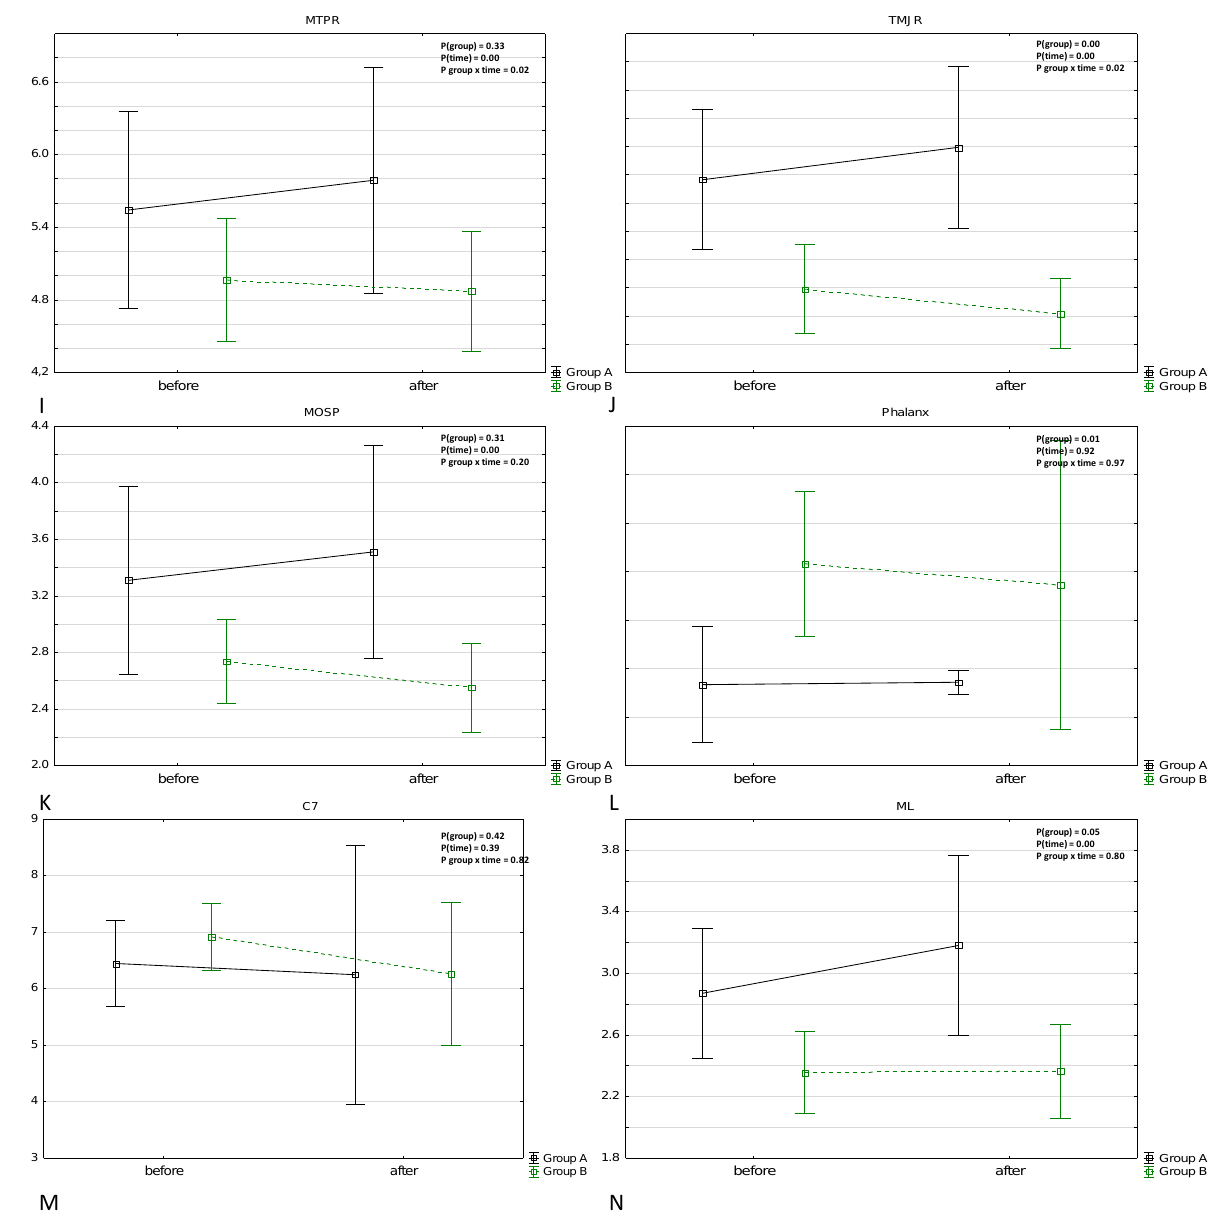
Figure 5. Results of algometric measurements among the subjects presented as box and whiskers plot. A: MTAL algometric measurements, B: MTML algometric measurements, C: MTPL algometric measurements, D: TMJL algometric measurements, E: MOSL algometric measurements, F: MR algometric measurements, G: MTAR algometric measurements, H: MTMR algometric measurements, I: MTPR algometric measurements, A: TMJR algometric measurements, K: MOSP algometric measurements, L: Phalanx algometric measurements, M: C7 algometric measurements, N: ML algometric measurements. All data are presented as Mean +/ − SD. Results of non parametric analysis for repeatable measurements (nparLD) are presented in the right corner of each